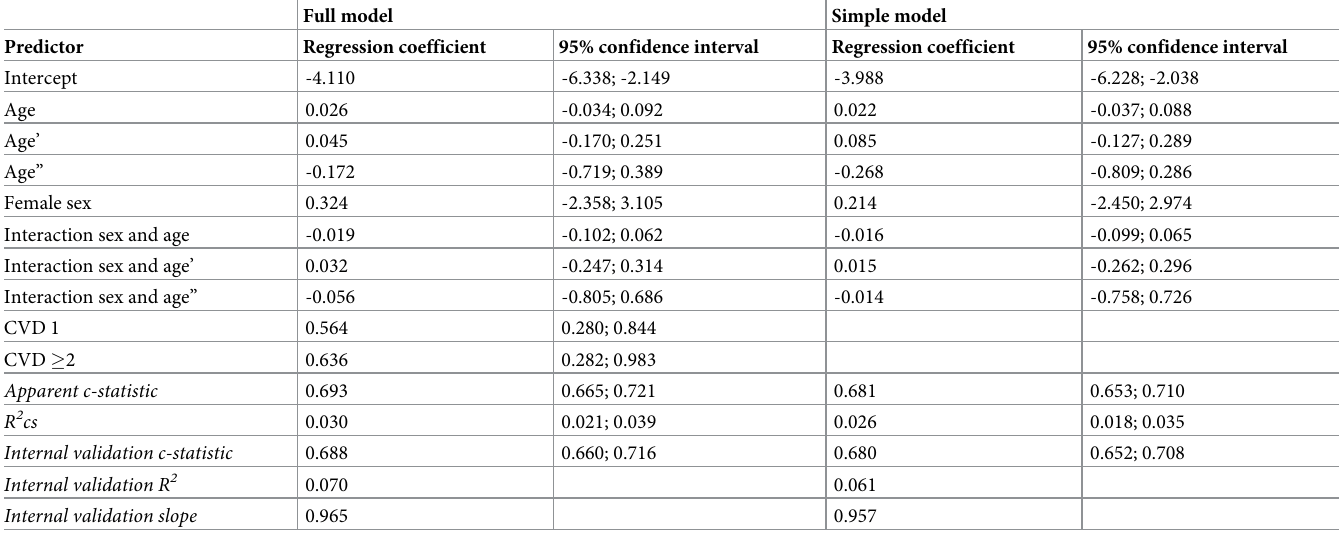
Table 3. Model development and internal validation using logistic regression.